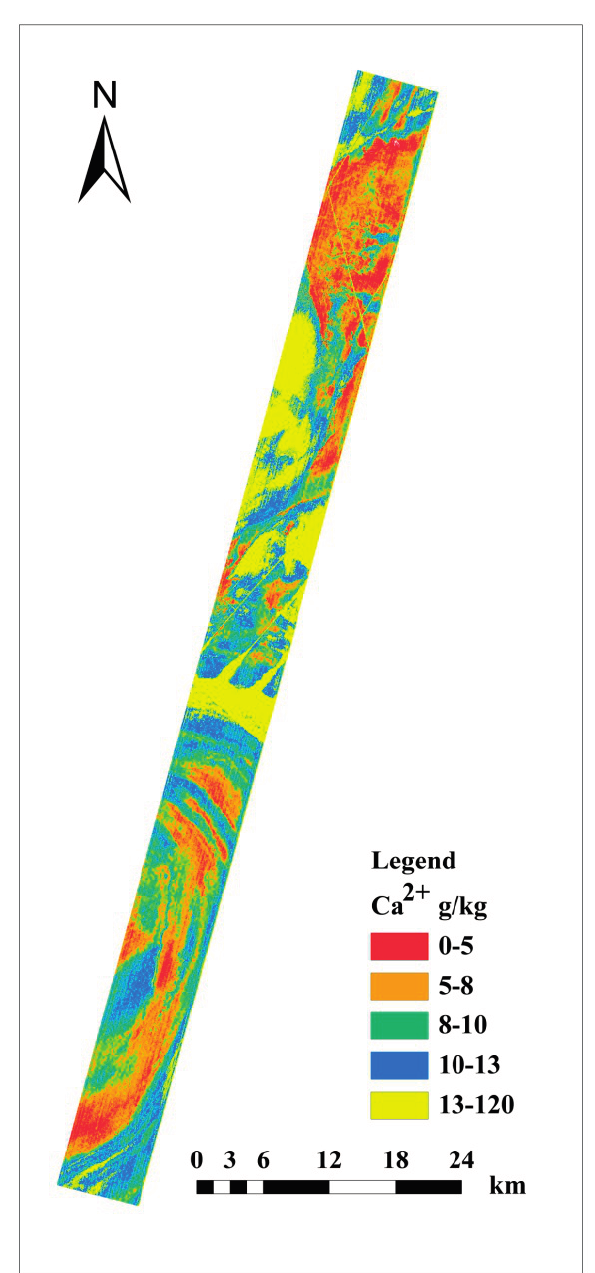
Figure 5. Ca 2+ abundance map derived by applying the PLS model to the Hyperion image. The location of the image is indicated by the oblique rectangular box in Figure